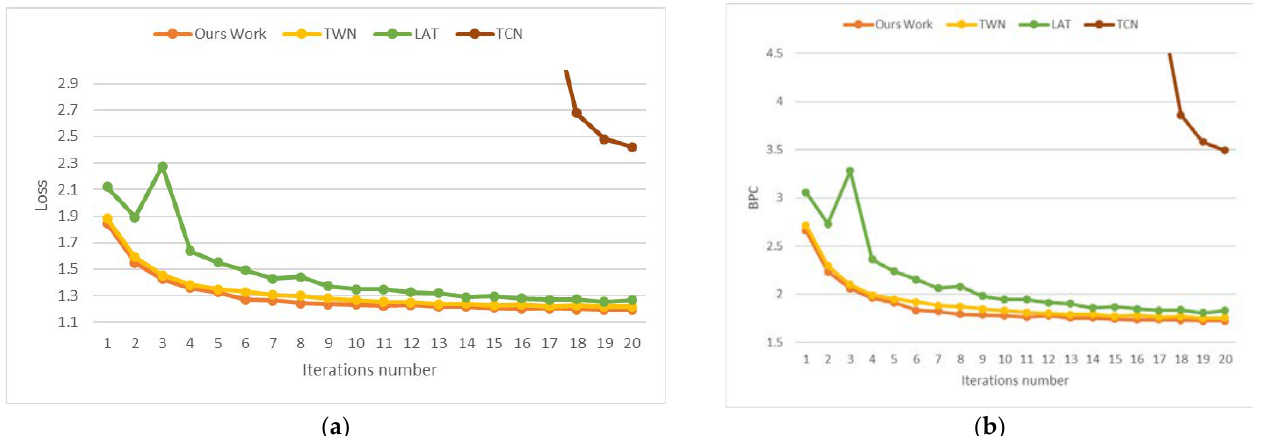
Figure 6. Comparison of the loss and BPC in the 2-bit quantization precision. ( a ) The 2-bit iteration curves of the loss. ( b ) The 2-bit iteration curves of the BPC.